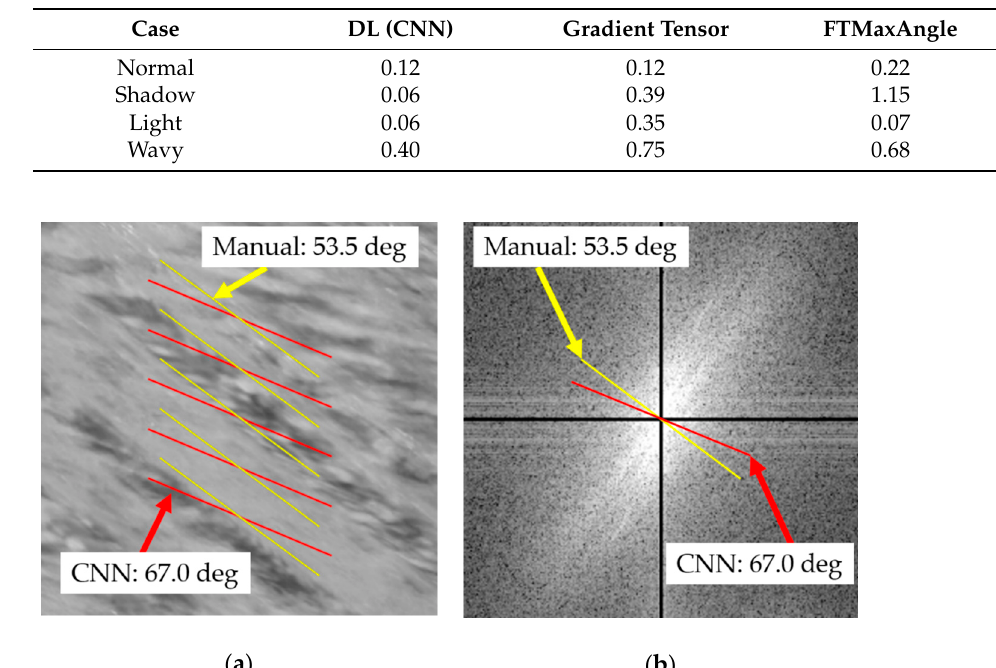
Figure 16. The false detection of peak angle case (red: CNN estimation, yellow: manual